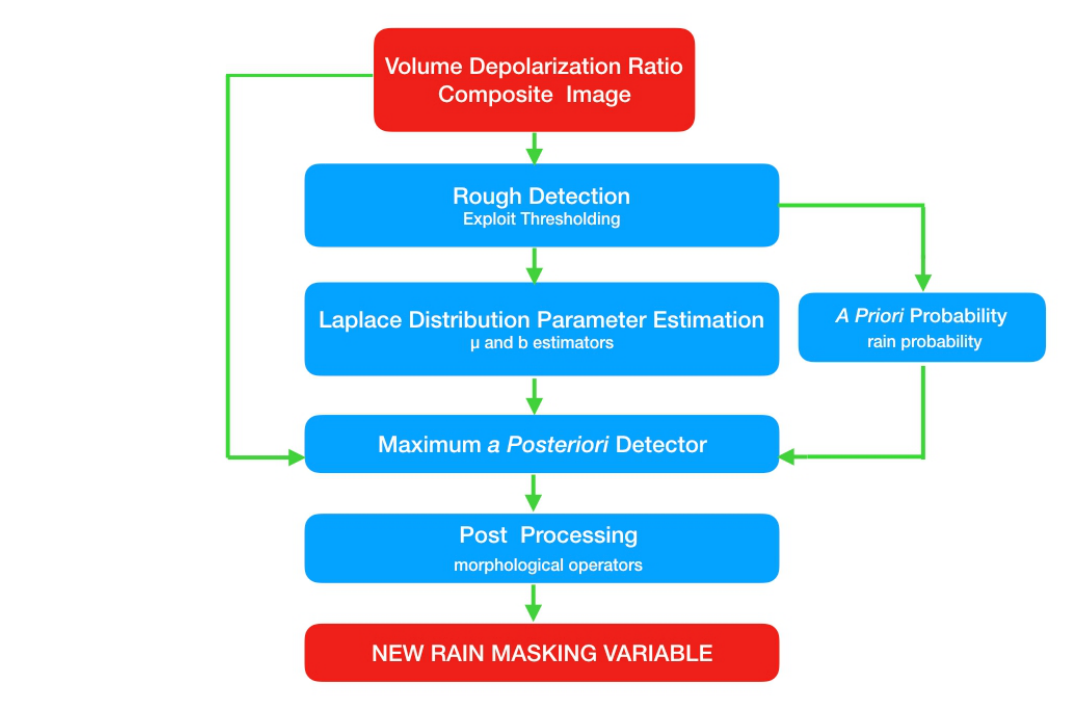
Figure 3. Flowchart of V3 MPLNET rain detection algorithm. Red boxes indicate data input/output, while blue boxes represent the processing steps. A detailed description of all the steps can be found in the